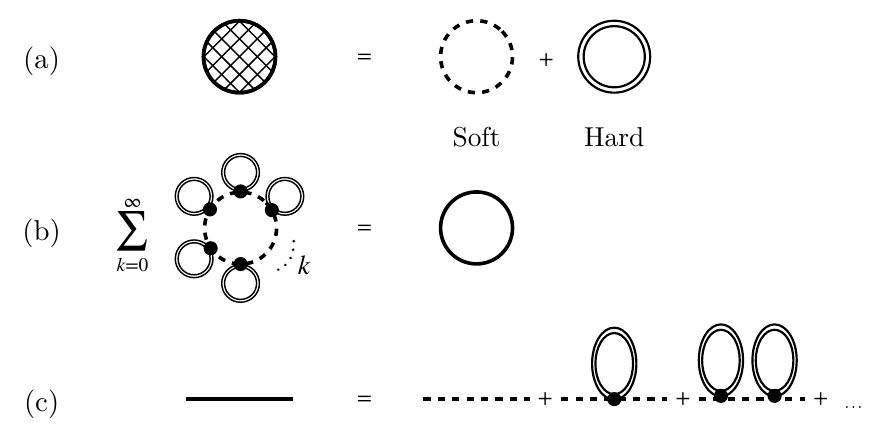
Figure 9 . Schematic illustration of leading daisy resummation. (a): division of the one-loop vacuum bubble into soft (dashed line) and hard contributions (double lines). (b): all-order resummation of the hard mode contributions to the soft term. (c): resummation of the soft scalar mass parameter. of the EFT have trivial relations to the 4d parameters, i.e. λ 3 ∼ T λ and v 2